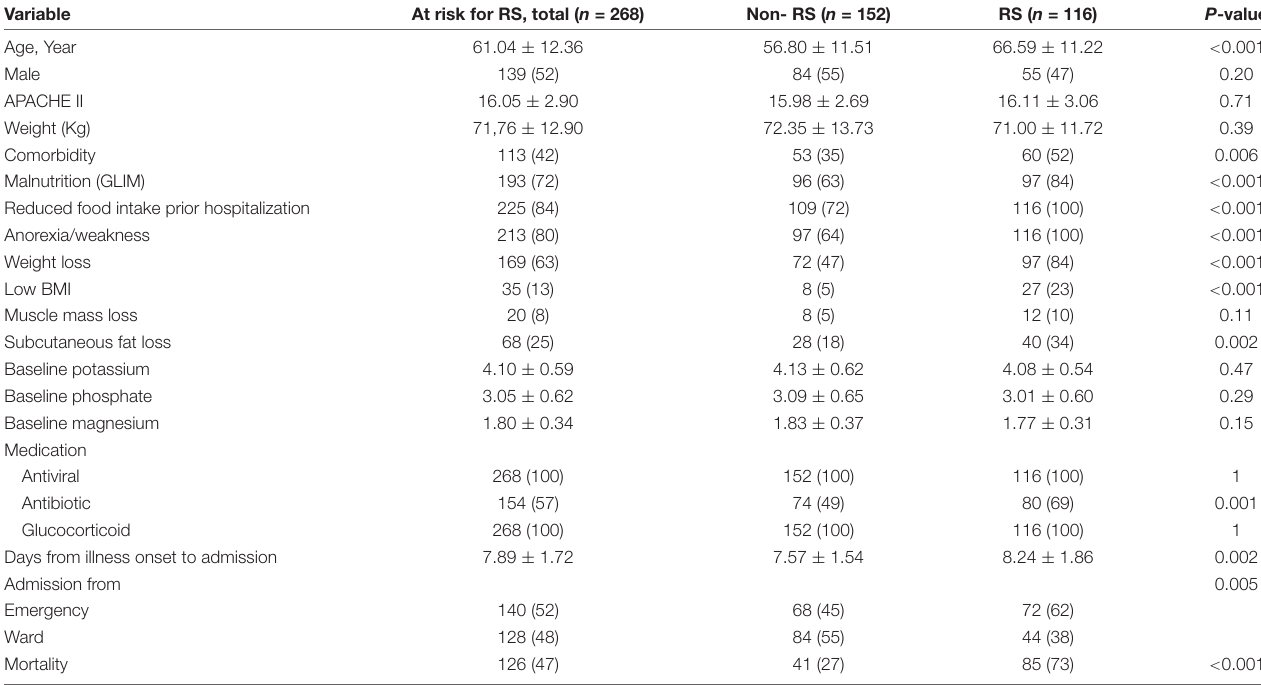
TABLE 1 | Demographic and clinical characteristics of at risk patients, stratified by Refeeding syndrome.